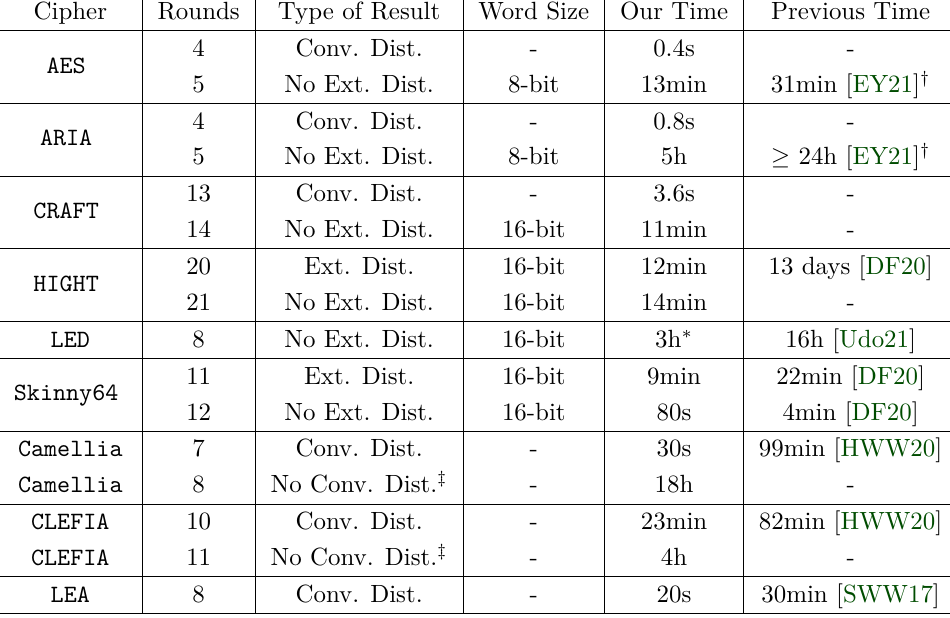
Table 1: Comparison of our solving times with previous works. ∗ Time required to find the relevant trails, see Section B.5 for more details. † Our implementation using [EY21] simple lazy constraints. ‡ With exact modeling for the linear layer, and all possible starting round for Camellia